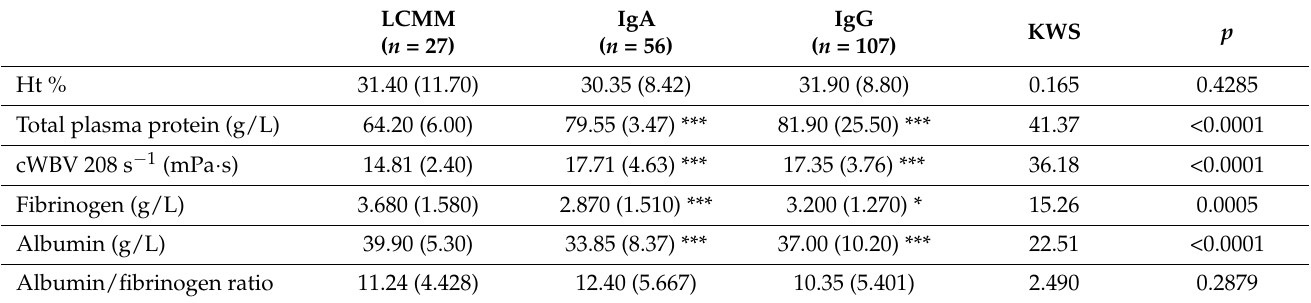
Table 3. Medians (IQRs) of hemorheological determinants in MM patients subdivided according to the isotype of the